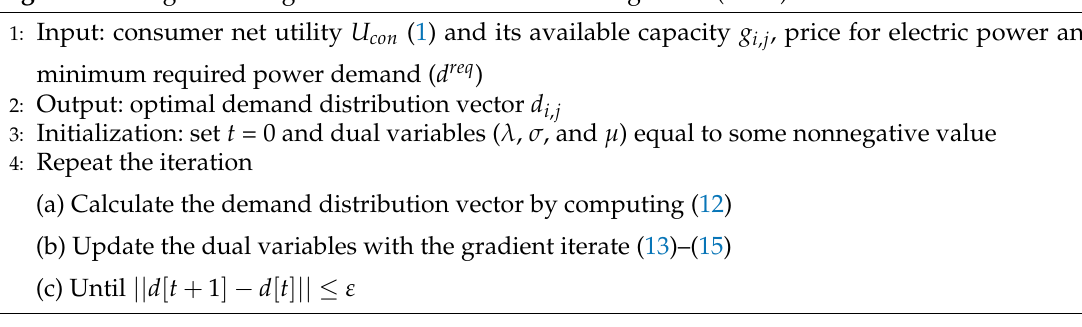
Algorithm 1 A gradient algorithm for demand-side management